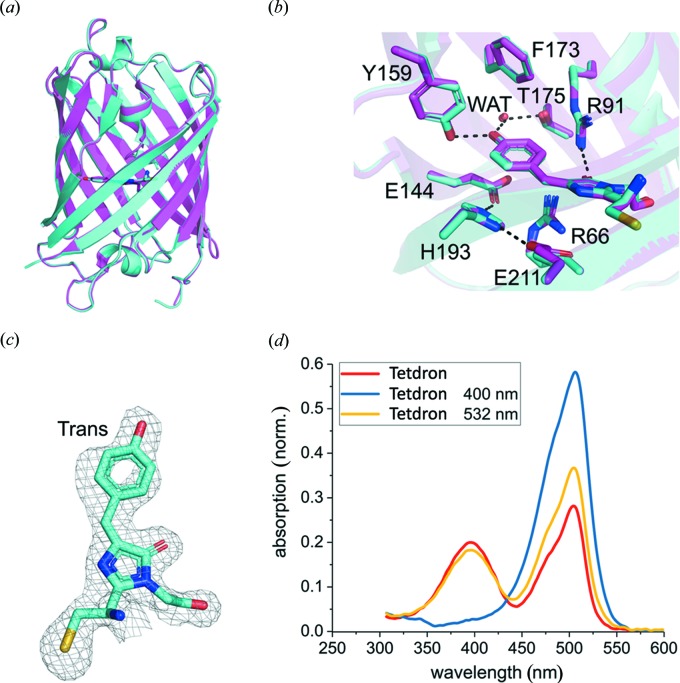
(a) Structure of the hydrogenated Tetdron monomer (cyan) at equilibrium aligned with Padron0.9 ‘off-state’ (magenta). (b) Structural alignment close-up of the chromophore site with surrounding residues of Tetdron (cyan) and Padron0.9 (magenta). (c) Electron-density map for the chromophore refined with 100% occupancy in the trans configuration for hydrogenated Tetdron at equilibrium (also see Supplementary Fig. S1). The grey mesh is a 2|F
o|−|F
c| electron-density map contoured at 1σ. (d) Solution UV–vis absorption spectra of Tetdron before (red line) and after (blue–grey and yellow lines) irradiation. The blue–grey spectrum was recorded after 400 nm irradiation, followed by 532 nm irradiation resulting in the yellow spectrum.